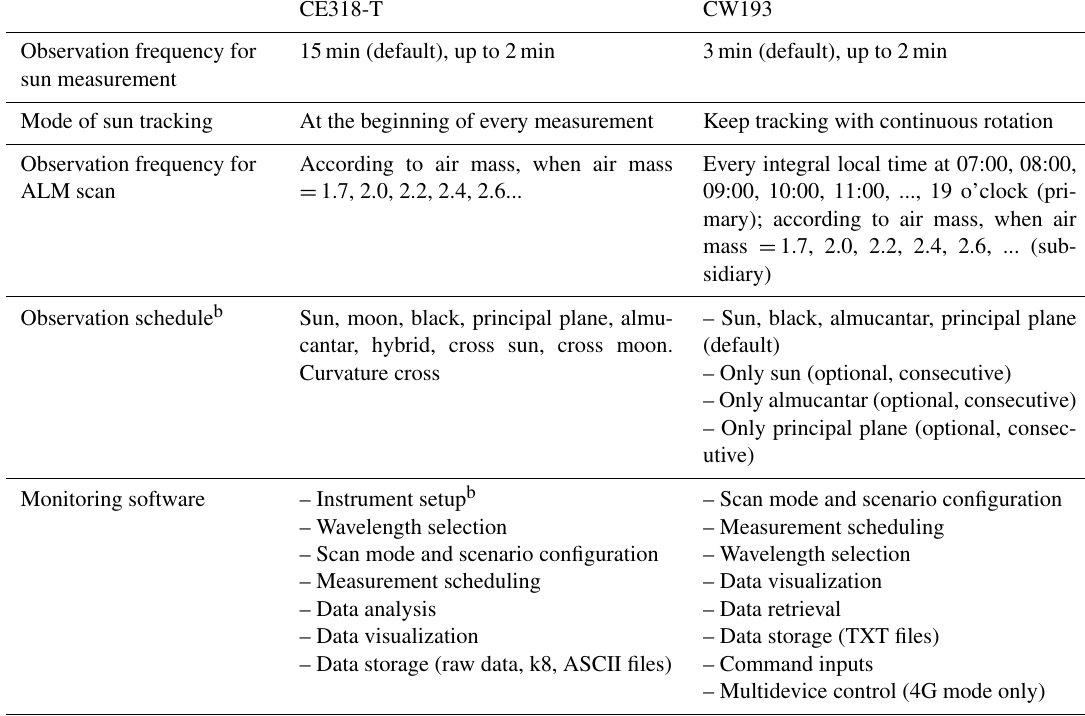
Table 2. Functional specifications for CE318-T a and CW193.